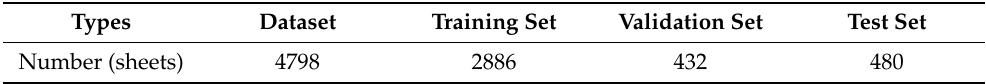
Table 3. Training set, validation set, and test